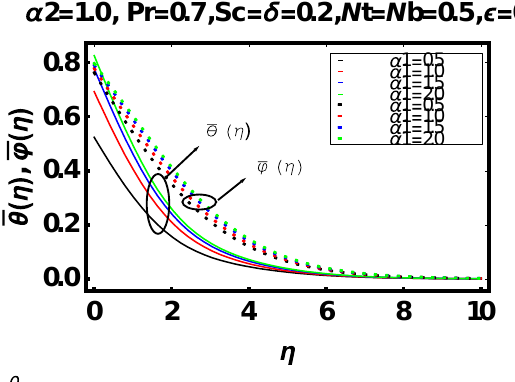
Figure 16. Temperature and concentration profiles for variant α 1 .